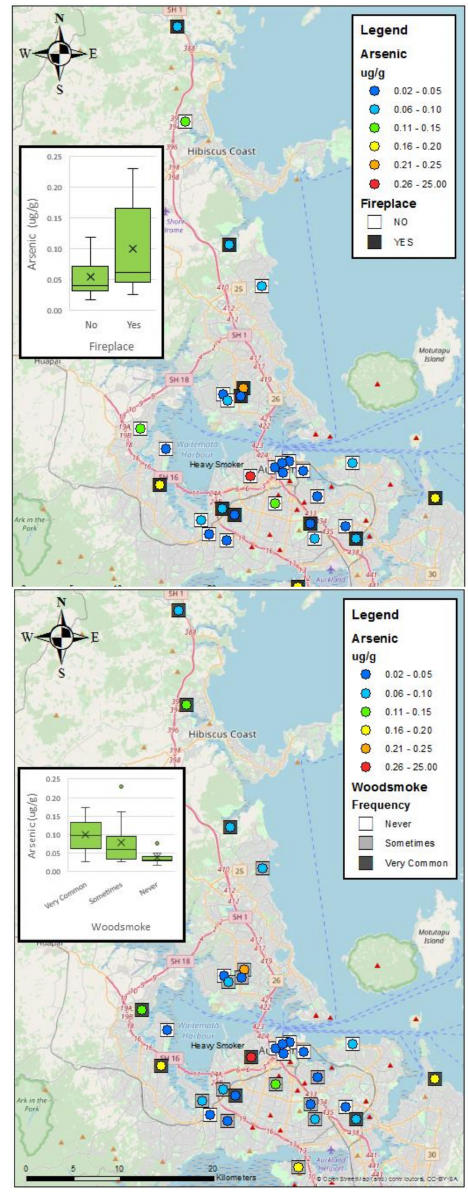
Figure 2. The map of study participants shows the estimated location, as well as the concentration of arsenic found in the beard sample. The left panel includes data on fireplace usage and the right panel shows the frequency of wood smoke present in neighbourhoods based on smell.